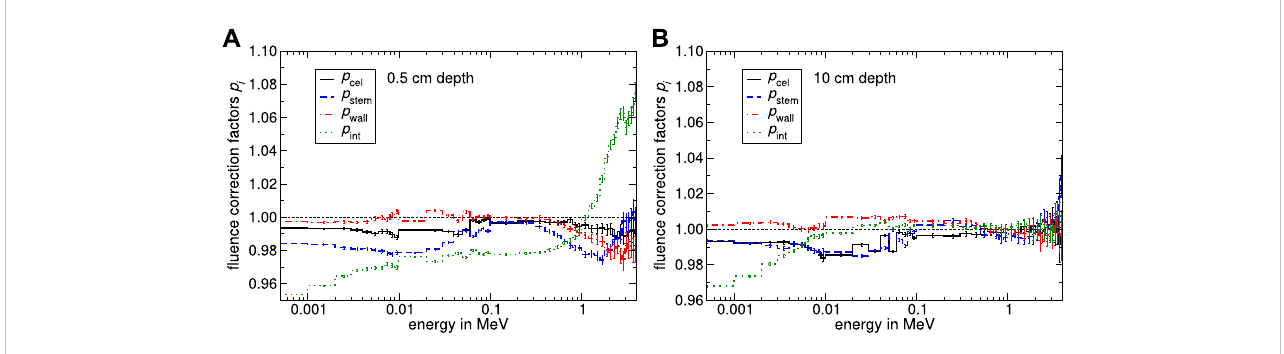
FIGURE 9 Monte Carlo calculated speci fi c fl uence correction factors p E , i for differentconstructive details from thePTW 31021 Semi fl ex 3Das a function of energy. Panel (A) shows the spectral speci fi c fl uence correction factors p E , i , whereby the shifted EPOM was positioned at 0.5 cm depth. In sub fi gure (B) p E , i was calculated at 10 cm depth. The uncertainty varies depending on energy in a range of 0.05% – 1%.